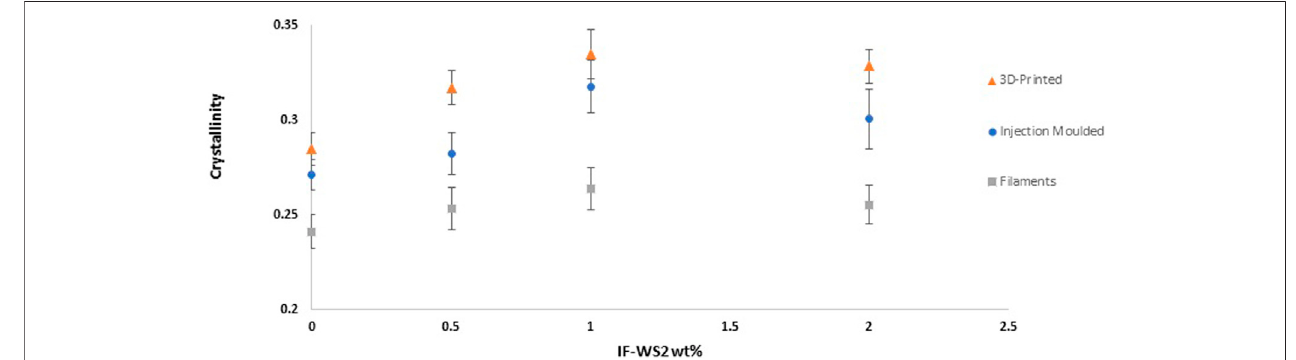
FIGURE 4 | Crystallinity of PEEK nanocomposites processed via extrusion, FDM and injection moulding.